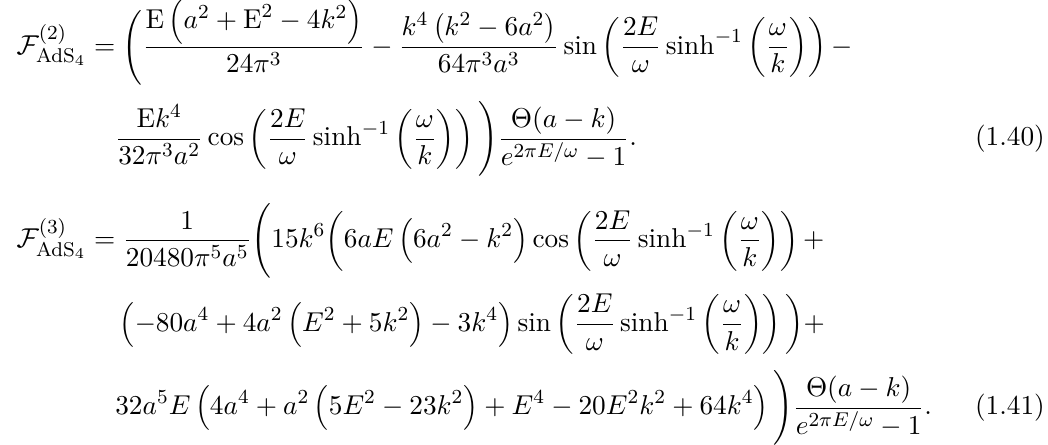
Figure 2 . Behaviour of detector response functions in (a) F (1) acceleration a for different values of energy E . Comparison of F (1) E = 4 and (d) E = 8 as we change the acceleration. In this plot we fixed AdS radius L = 1 .